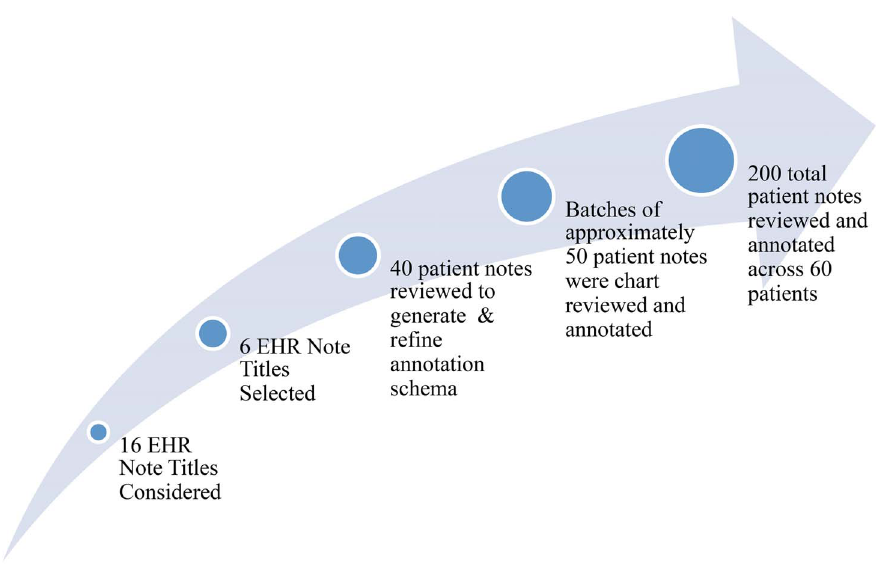
Fig. 1. EHR Note Title Selection, Annotation Schema, Chart Review &